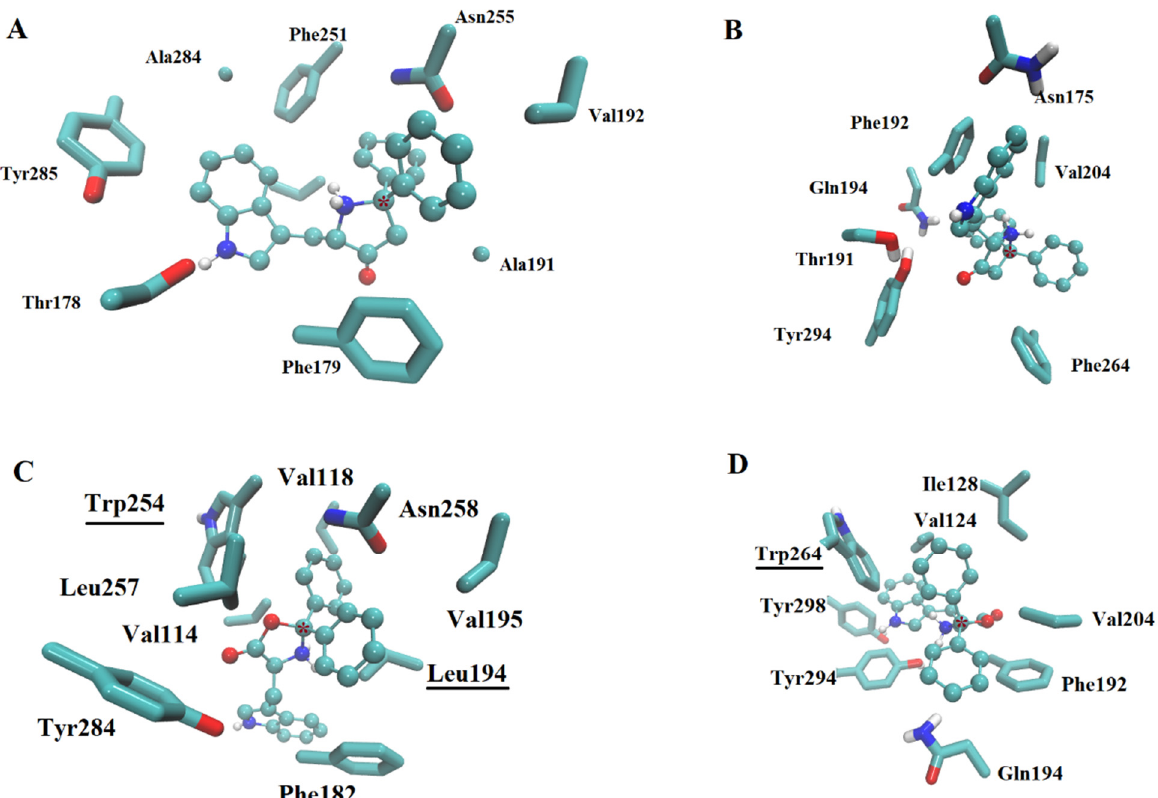
Figure 5. Docking of borolatonin (in sticks and balls representation) on melatonin receptors. Binding site on the crystalized human MT1 ( A ), MT2 ( B ), and the built models of rat MT1 ( C ) and MT2 ( D ). All sidechains of residues are labeled in licorice representation. Underlined residues marked in the lower panels are different in the binding site of the homologous human receptor. Asterisk is in the boron atom of each borolatonin molecule. In the D panel, Thr 191 and Asn 175 were not included for clarity. Oxygen atoms are in red color, nitrogen atoms are in blue color.